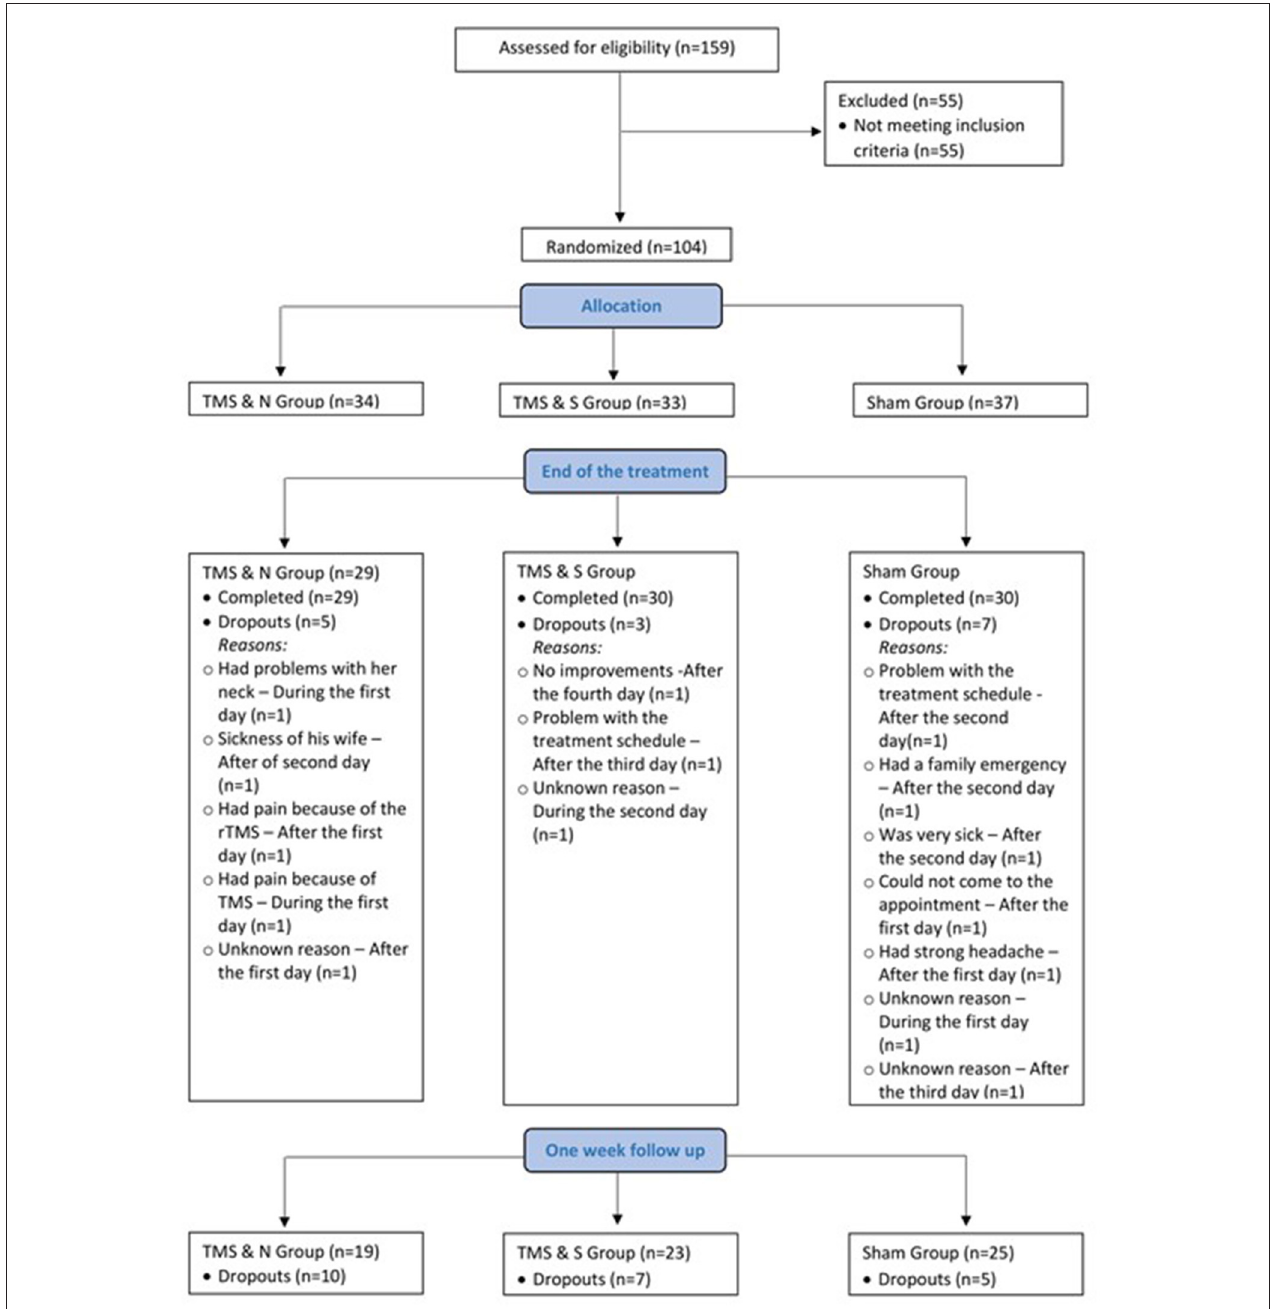
FIGURE 1 | Flow chart of the selection procedure.